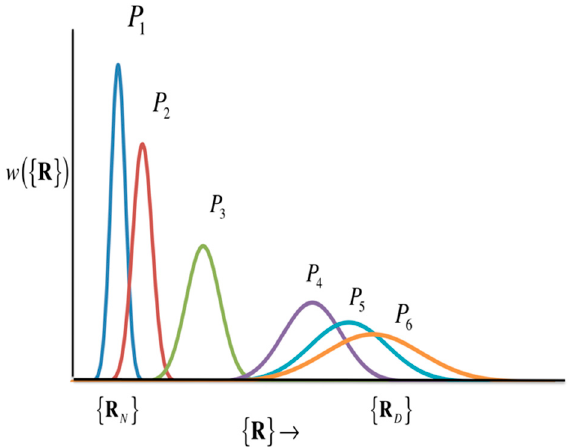
Figure 15. Schematic diagram showing the structural transition of proteins. (The figure is reprinted from Ref. [103]. Copyright (2018) American Institute of Physics.)